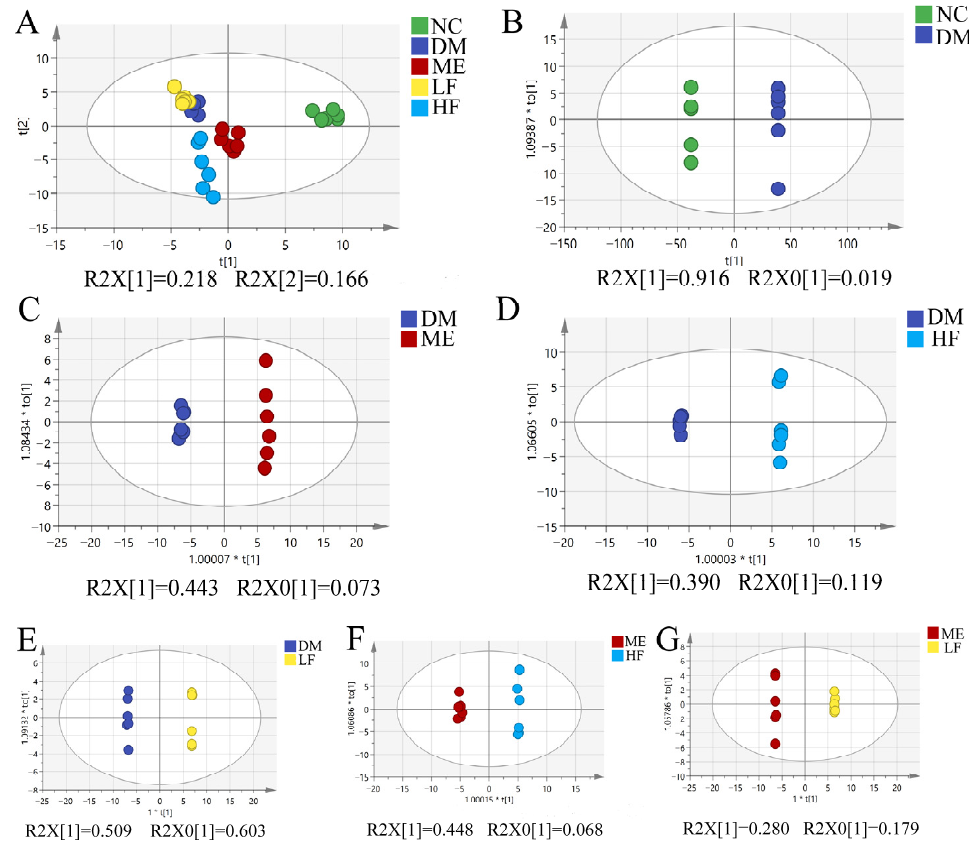
Figure 9. Untargeted metabonomics analysis of fecal samples by using AB Triple TOF 5600. PCA ( A ) and OPLS-DA between groups ( B – D ).